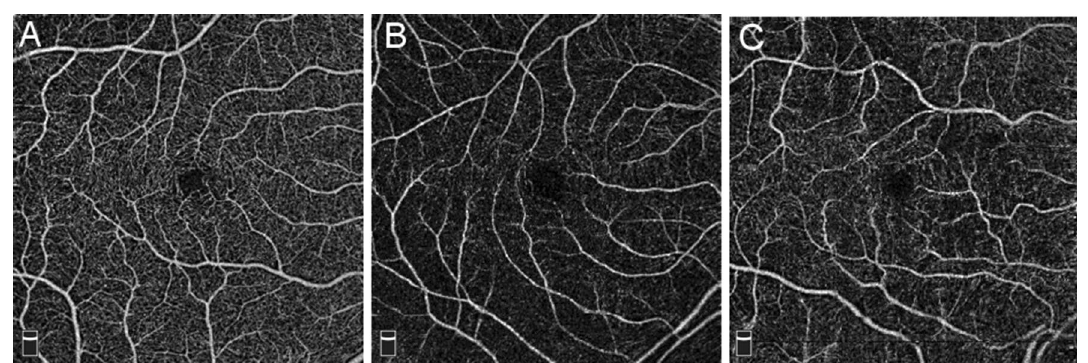
Figure 4. Superficial macular OCT-A image samples demonstrating differences in capillary density. ( a ) High capillary density (foveal density 51.5) in a participant with normal vascular stiffness (PWV 8.8 m/s) and healthy kidney function (eGFR = 90 mL/min/1.73 m 2 ). ( b ) Low capillary density (foveal density 21.7) in a participant with high vascular stiffness (PWV 12.2 m/s). ( c ) Low capillary density (foveal density 29.7) in a participant with impaired kidney function (eGFR = 29 mL/min/1.73 m 2